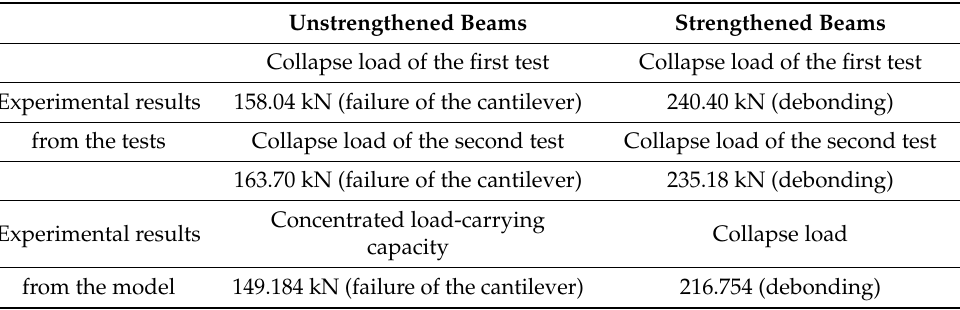
Table 2. Comparison between the experimental results from the four collapse tests (failure concen- trated force of each test and observed failure mode) and the theoretical results from the analytical model (concentrated load-carrying capacity P ud and theoretical failure